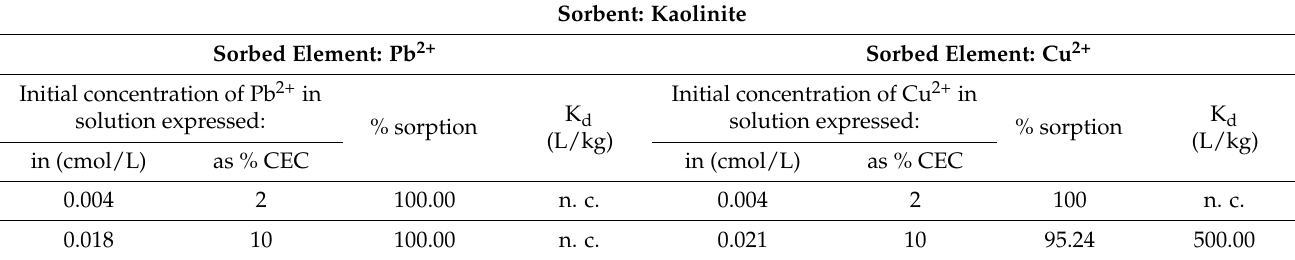
Table 2. The results of the examination of sorption of Pb 2+ and Cu 2+ onto tested natural mineral sorbents—% sorption and K d